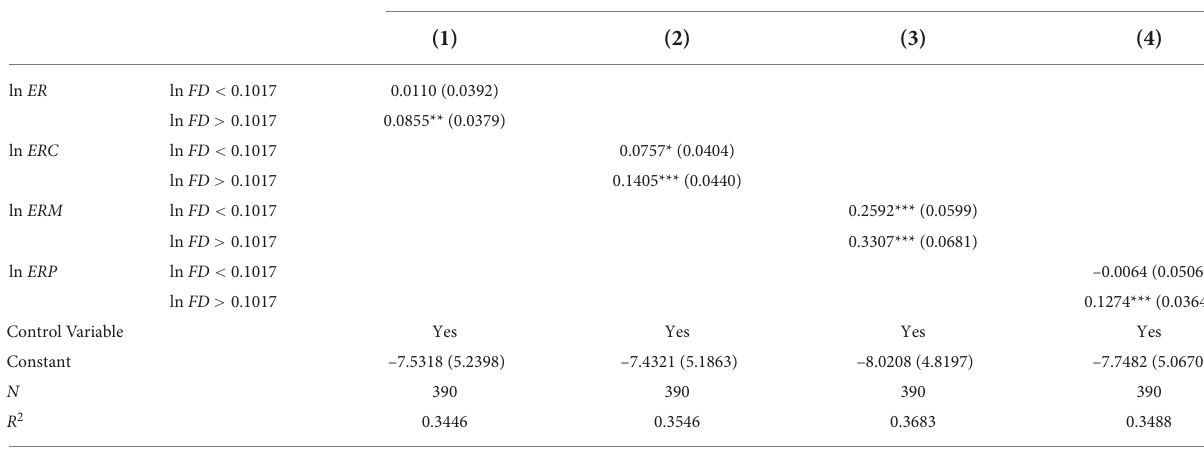
TABLE 8 Regression results of the fiscal decentralization threshold model.